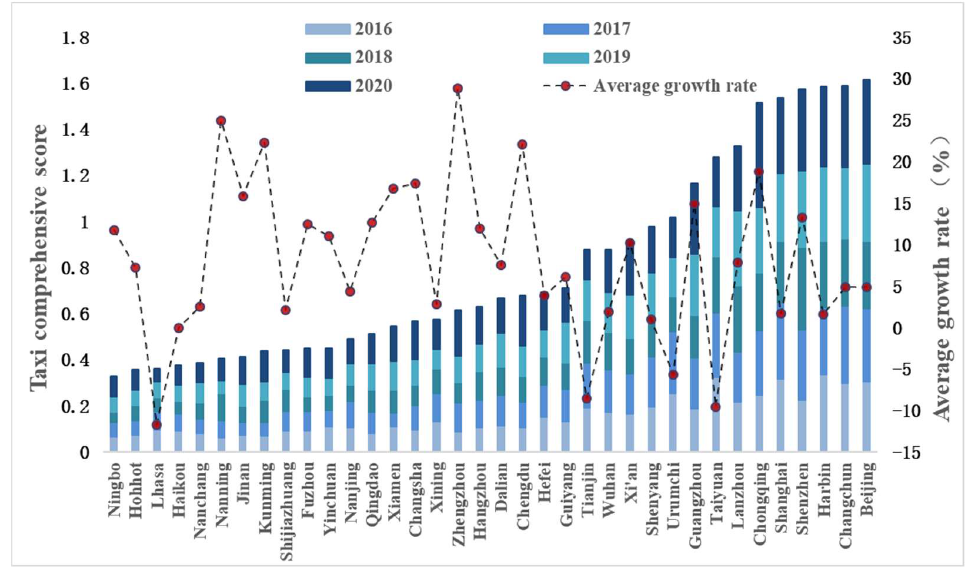
Figure 4. Changes in the comprehensive development level of taxis in 36 cities in China.